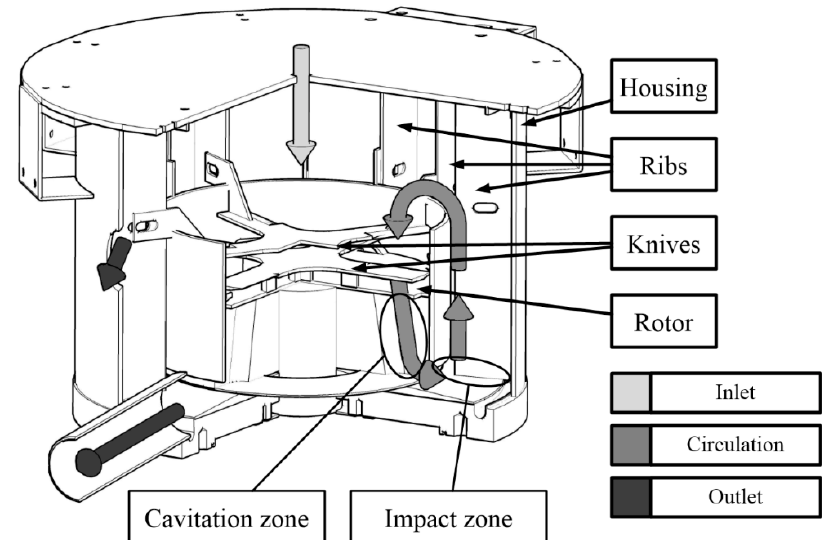
Figure 8 . Diagram of the disintegrator. Figure 8. Diagram of the